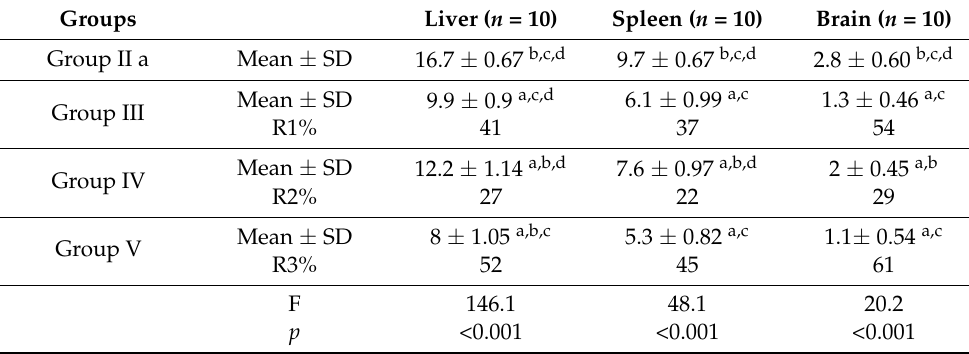
<0.001 <0.001 <0.001 a Significant with subgroup II; b Significant with subgroup III; c Significant with subgroup IV; d Significant with